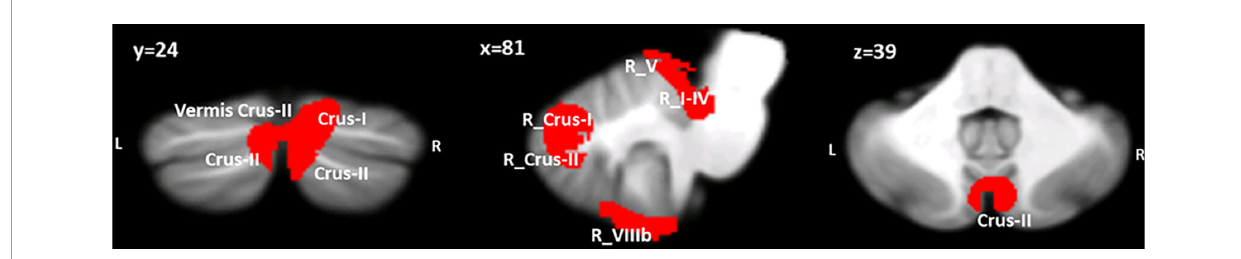
FIGURE2 Between-group voxel-based comparison of cerebellar GM density. Clusters of significantly reduced cerebellar GM in BD compared to HS-MRI are reported and superimposed on the Spatially Unbiased Infratentorial Template (SUIT) (Diedrichsen et al., 2009) in coronal (y), sagittal (x) and axial (z) slices. The results are significant at p -values < 0.05 after FWE cluster-level correction. L: left; R: right.